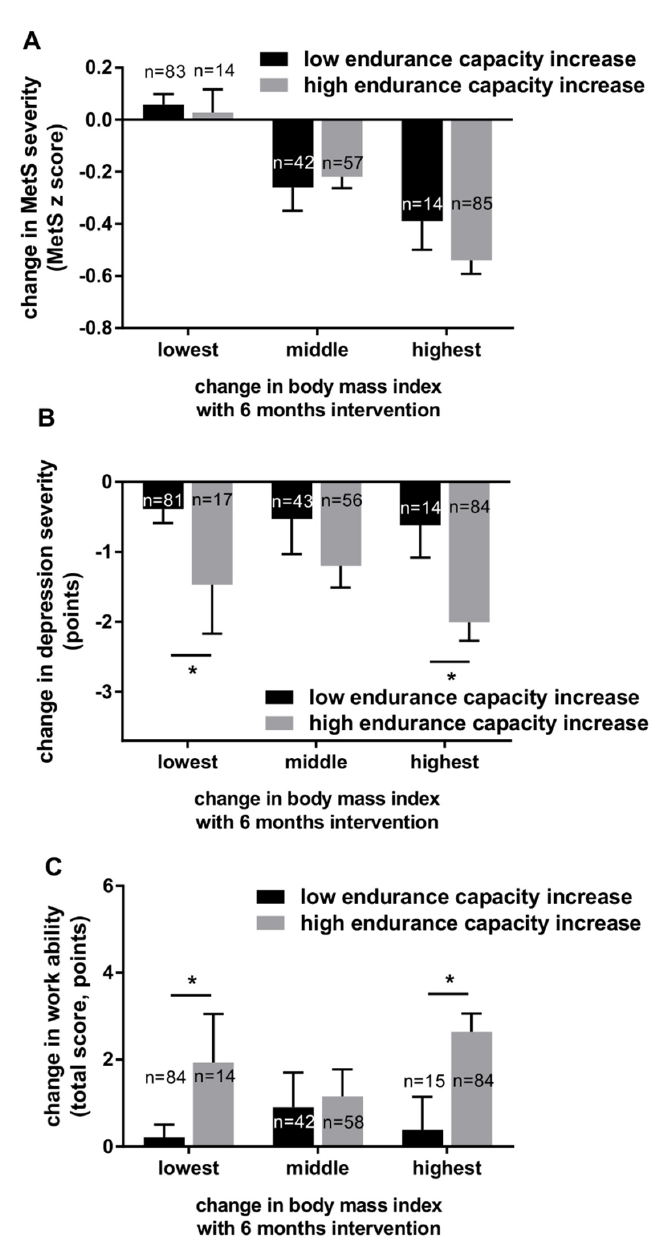
Figure 3. 6-month intervention induced changes in MetS severity ( A ), changes in depression severity ( B ), and changes in work ability ( C ) classified into tertiles of BMI changes and further subgrouped for changes in exercise capacity (low: black columns; high: grey columns) during the intervention. Data are mean ± SEM, * p < 0.05, significantly different for absolute exercise capacity changes among the same BMI change tertile.